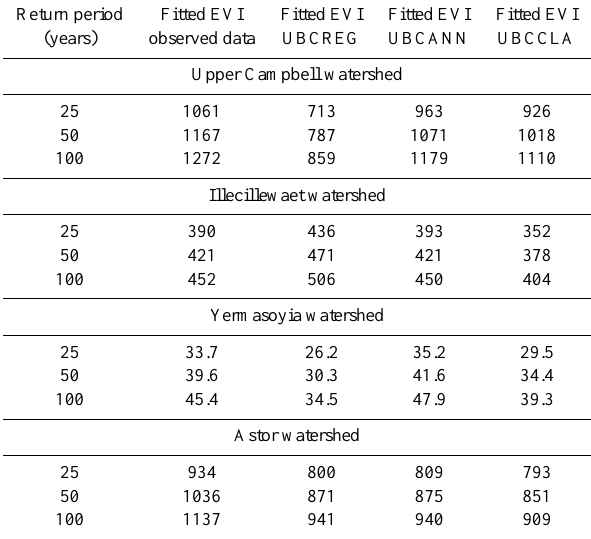
Table 8. Flood frequency estimation using annual maximum peak flows (m 3 s − 1